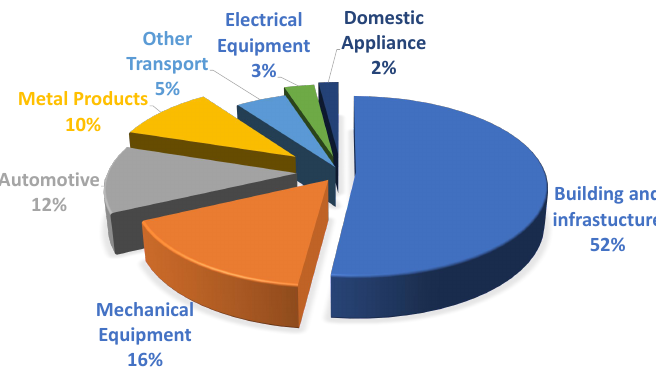
Figure 2. Annual crude steel production, per industrial consumer sector; Graph created from data taken from source